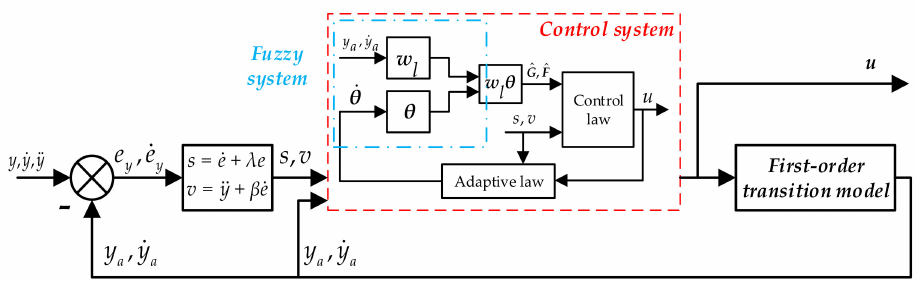
Figure 5. The resistance moment